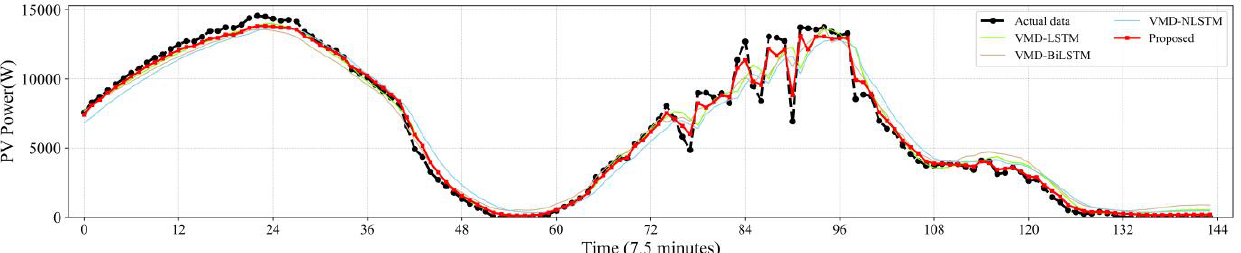
Figure 11. Contrasting the performance evaluation of the proposed model and LSTM networks combining VMD.